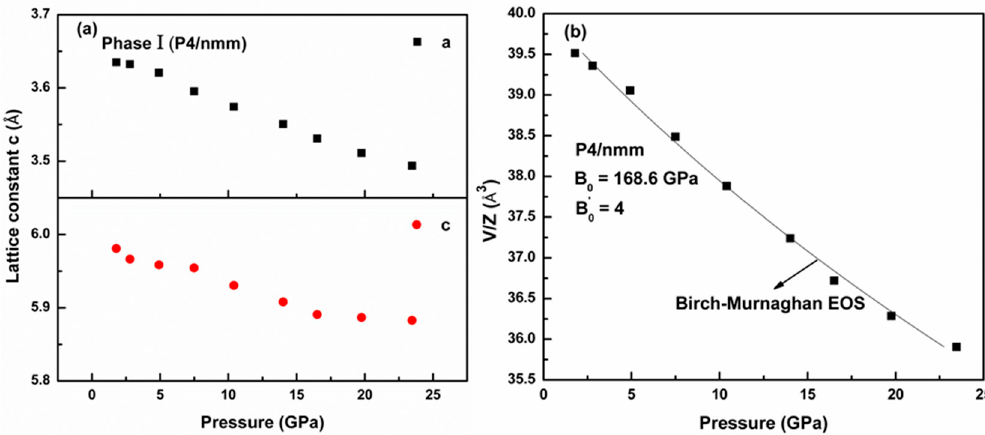
Figure 5. ( a ) Pressure dependence of the lattice constants a and c for P 4 / nmm phase; ( b ) Unit cell volumes versus pressure. The solid line shows the fitting curve using the third-order Birch–Murnaghan equation of states.